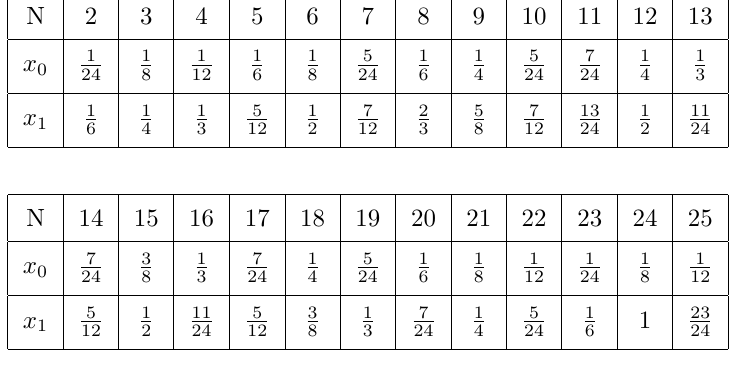
Table 1 . Values of x 0 ( Z N ) and x 1 ( Z N ) for N = 2 , . . . , 25